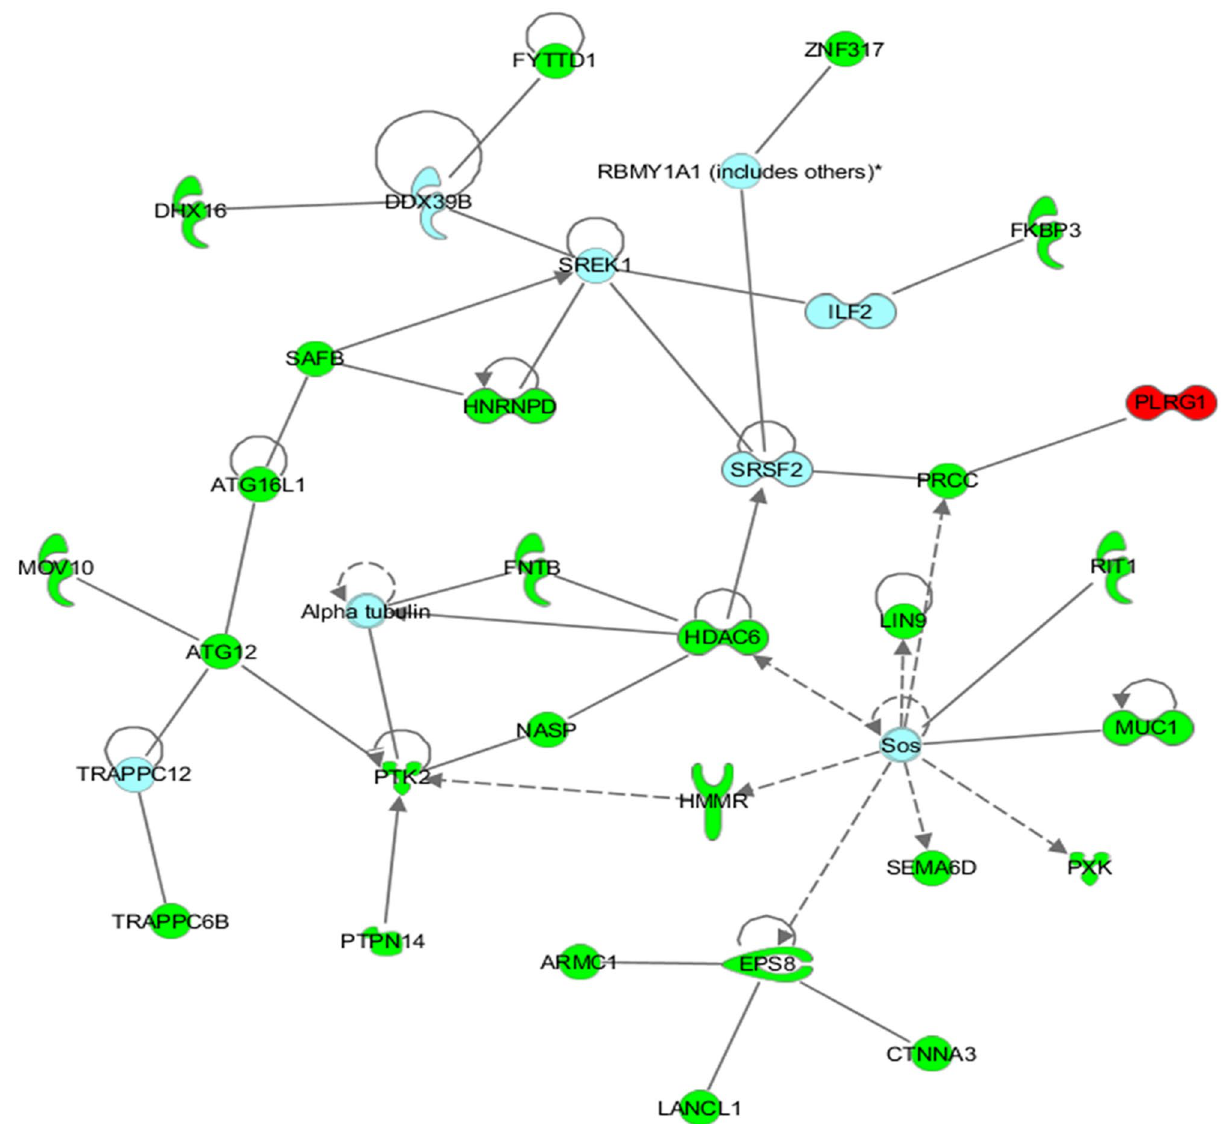
Figure 6. Network of interactions significantly enriched for genes displaying altered methylation patterns following treatment with valeric acid. This network was identified by the IPA as being the most significantly associated with the set of input genes and molecules within this network have functional relevance in “RNA post-transcriptional modification, Cancer, and Developmental disorder” ( p = 10E−59). Of the 27 genes present in the network, 26 were significantly hypermethylated are shaded in green, while only 1 was hypomethylated are shaded in red. Each interaction is supported by at least one literature reference identified in the Ingenuity Pathway Knowledge Base, with solid lines representing direct interactions, and dashed lines representing indirect